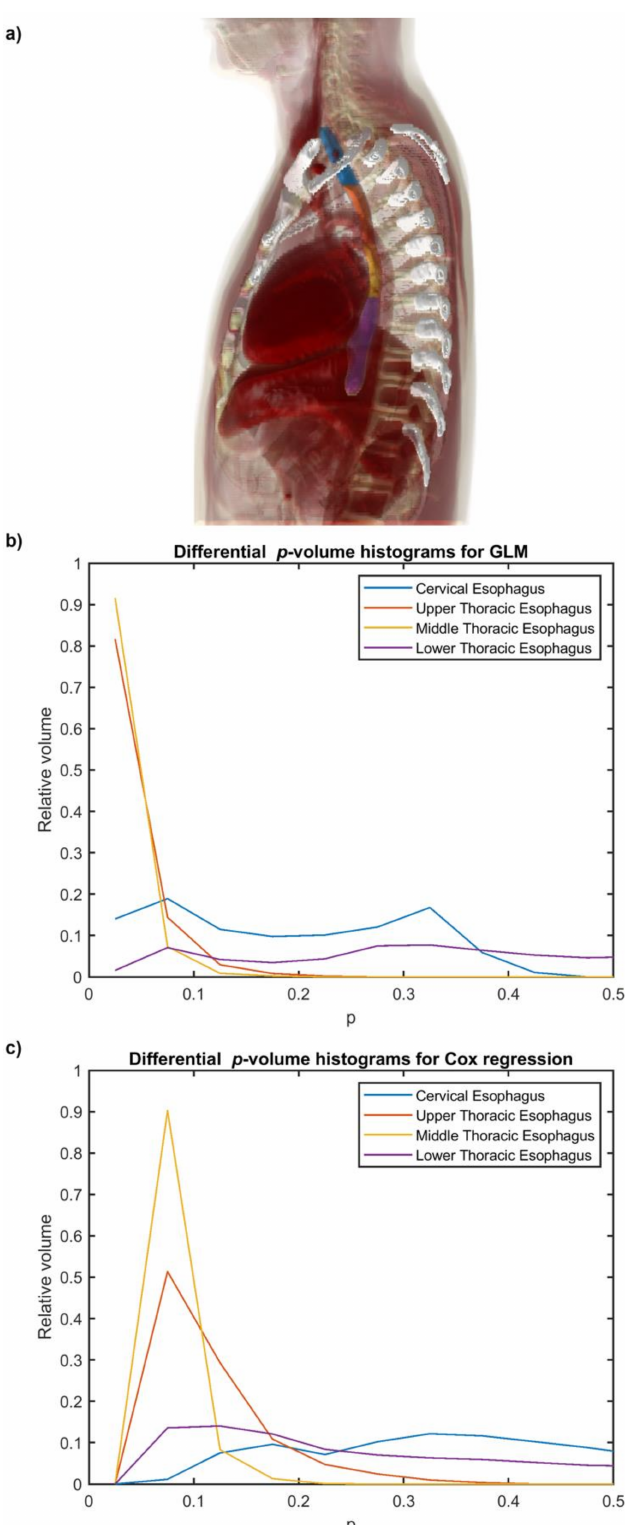
Figure 3. 3D volume rendering of the segmented esophageal subsites on the digital phantom ( a ). Relative differential p -volume histograms for esophageal subsites according to voxel-based GLM ( b ) and voxel-based actuarial regression ( c ) of RE. Blue: cervical esophagus, orange: upper thoracic esophagus, yellow: middle thoracic esophagus, and violet: lower thoracic